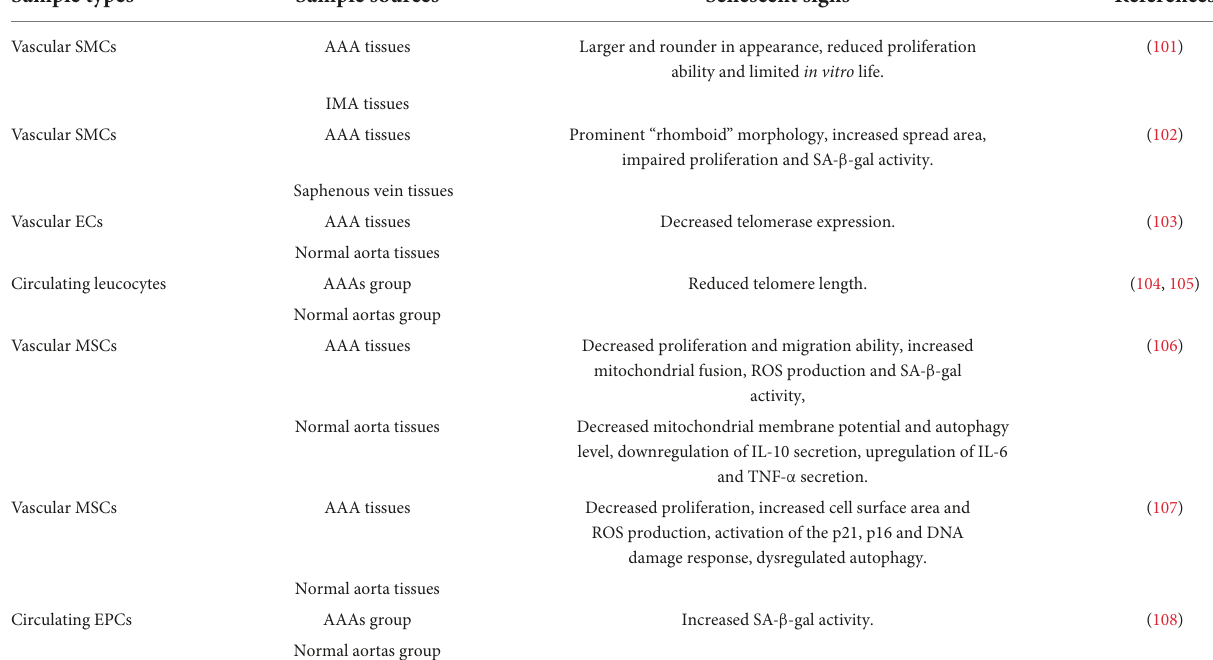
TABLE 1 Evidence of cell senescence in the aneurysm